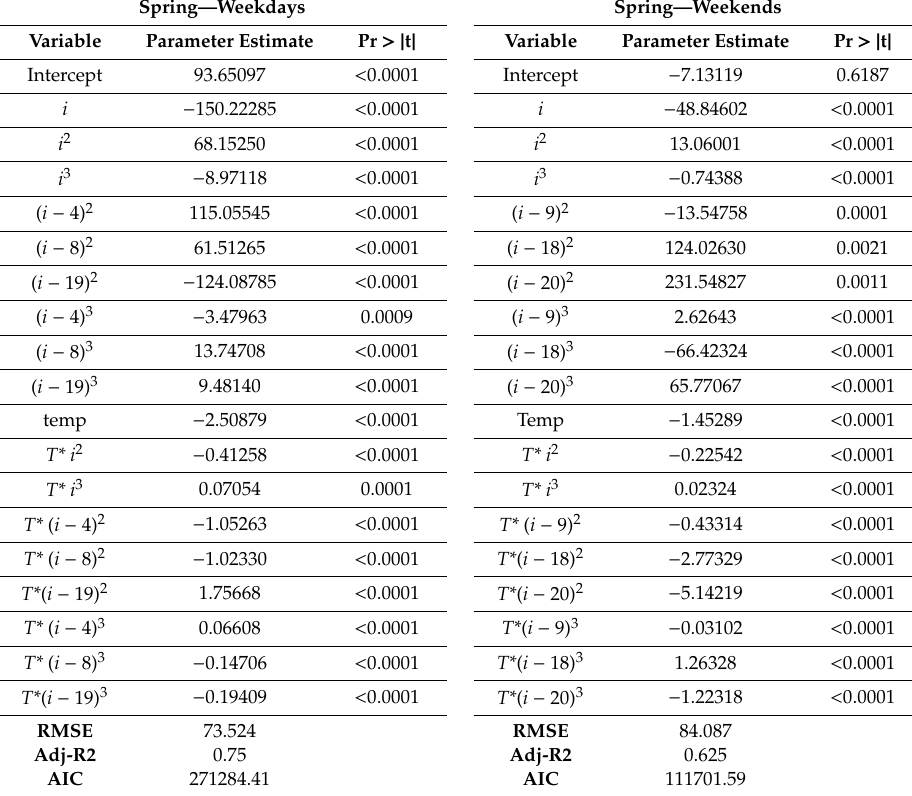
Table A3. The Results for the Regression Model for the Spring Season (Model